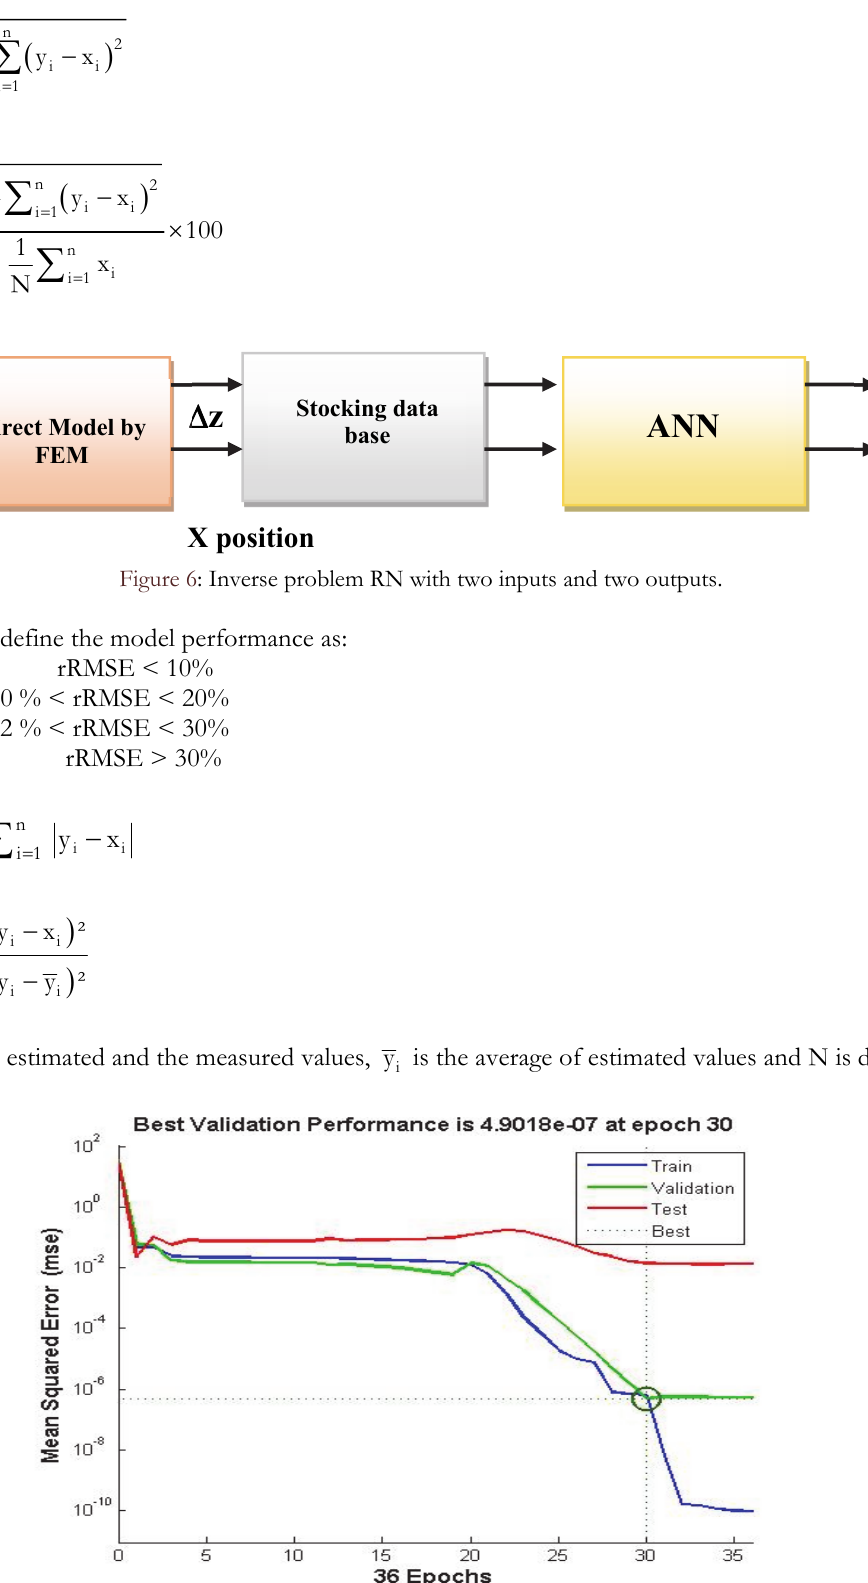
Figure 7: Cost function (MSE) vs. number of